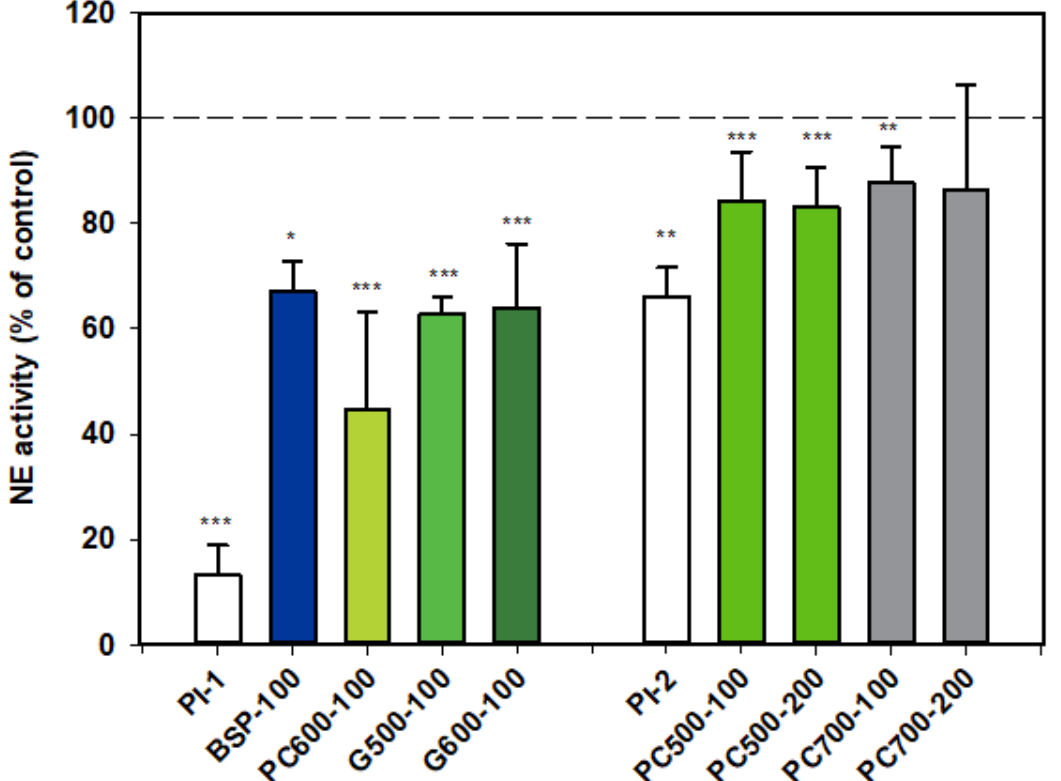
Figure 1. Neutrophil elastase activity relative to the control, two datasets. Values are means and SD (represented by error bars). Different coloured bars refer to different ingredients as indicated on the bottom axis (as described in Methods section and Table 1), with the last set of digits on each label indicating the ingredient dose ( µ g / mL). The positive control α -1-proteinase inhibitor (PI, 100 µ g / mL) is shown prior to the samples in each series (PI-1 and PI-2 referring to series 1 and 2). Values for Series 1 represent the means from 1 experiment with triplicate measurements, or pooled means from 2 independent experiments, each with triplicate measurements. Values for Series 2 represent the pooled means from 2 or 3 independent experiments, each with triplicate measurements. The first series represents data where only % Control (mean, SD, and p -value) was originally recorded. Significance relative to control, * p < 0.05; ** p ≤ 0.01; *** p ≤